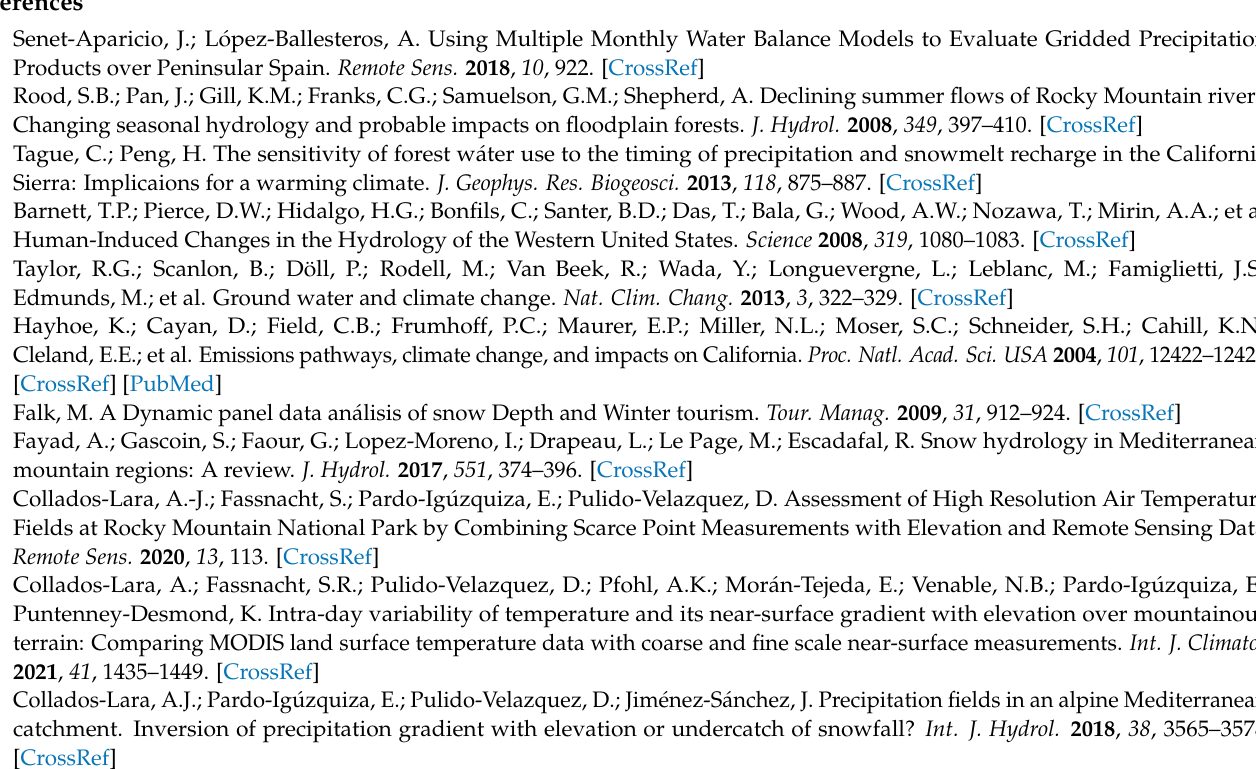
Figure A8. Historical and future hydrological drought ( a ) frequency; ( b ) mean duration; ( c ) mean magnitude; ( d ) mean intensity derived from SSCI for the 12 months temporal-aggregation scale.